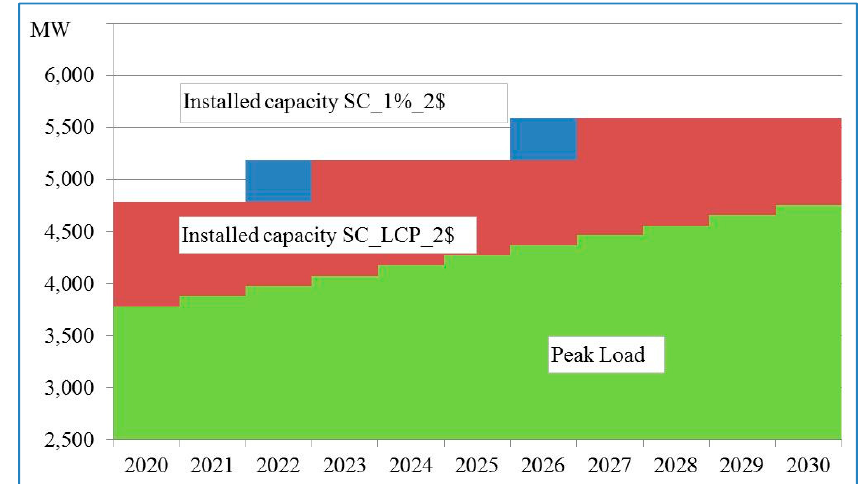
Figure 16. Scenario with VOLL $2 USD/kWh and LOLP = 1% versus the scenario with LCP.